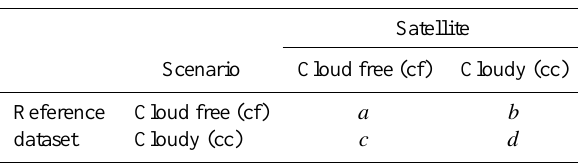
Table A1. Contingency table of satellite and synoptic/reference satellite (reference dataset)